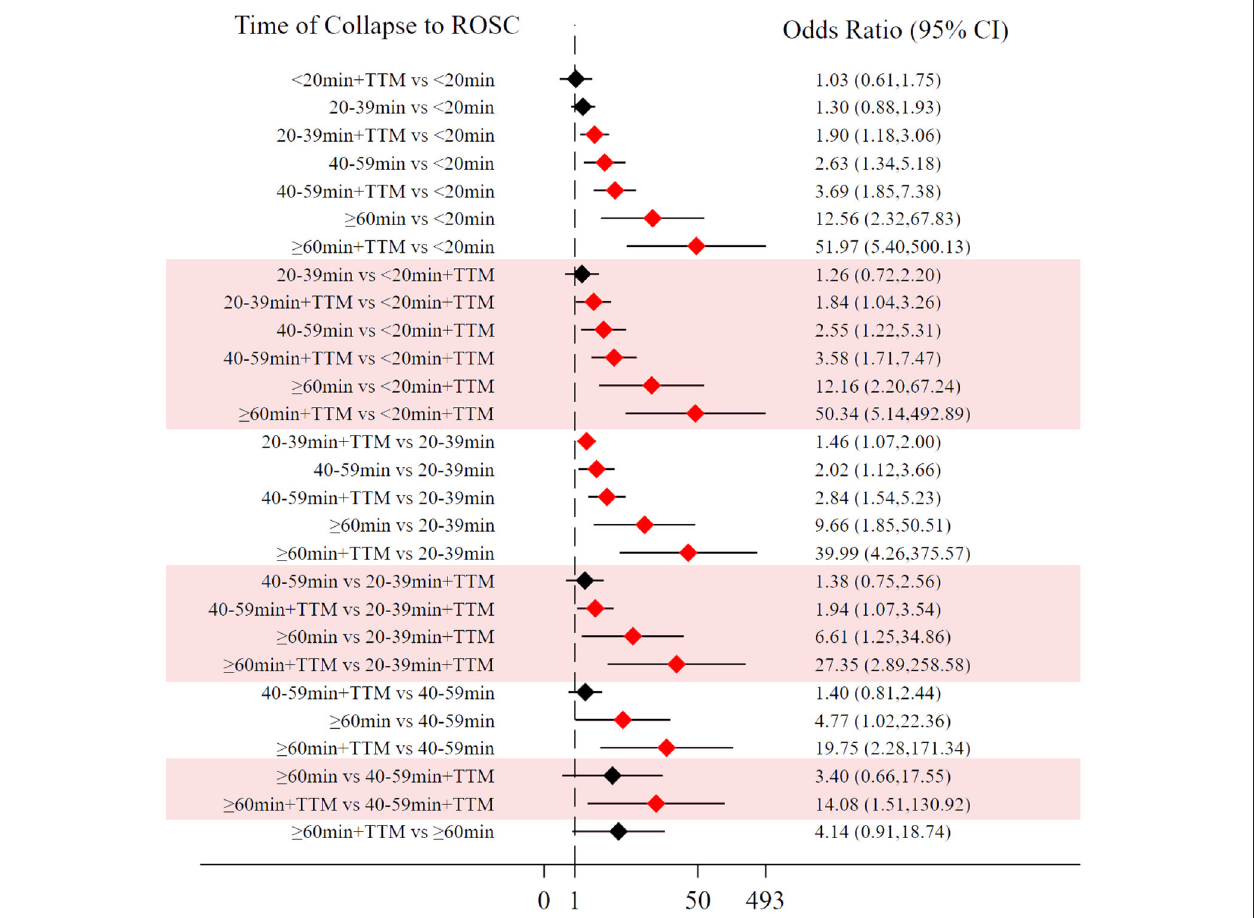
FIGURE 7 | Forest plot for good neurologic outcome (the stepped distributions of each group’s comparison with the same given group are shown in the same background color).